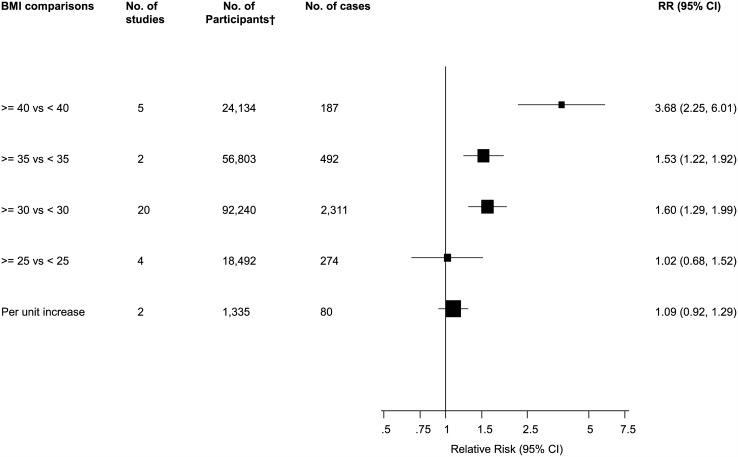
Body mass index comparisons and risk of periprosthetic joint infection.CI, confidence interval (bars); RR, relative risk; †, are number of participants or arthroplasties.